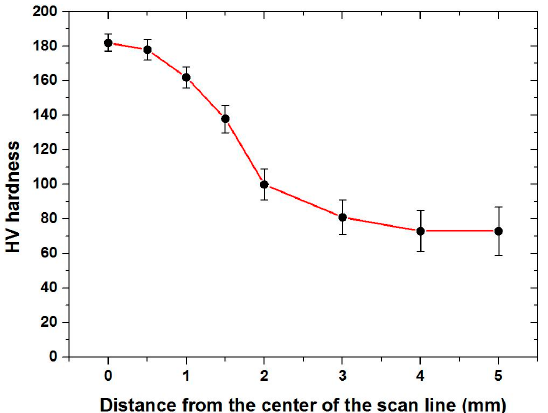
Figure 10. Schematic diagram of hardness as distance from the center of the scan line.